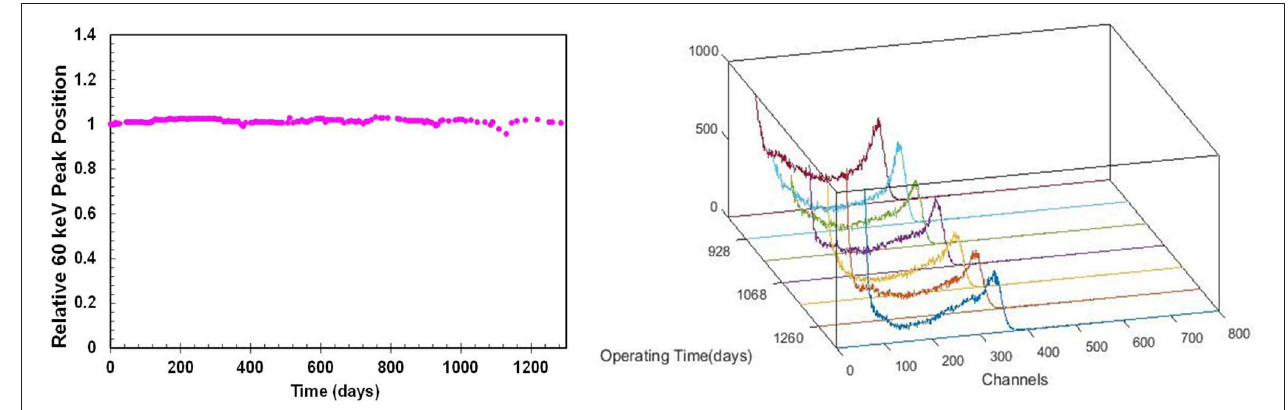
FIGURE 13 | Photograph of three TlBr-based SPRDs.